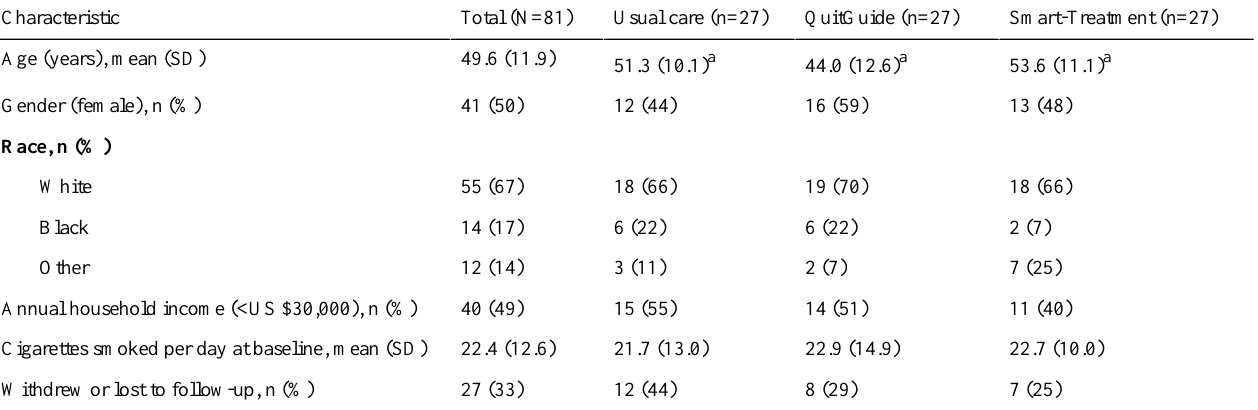
Table 1. Participant